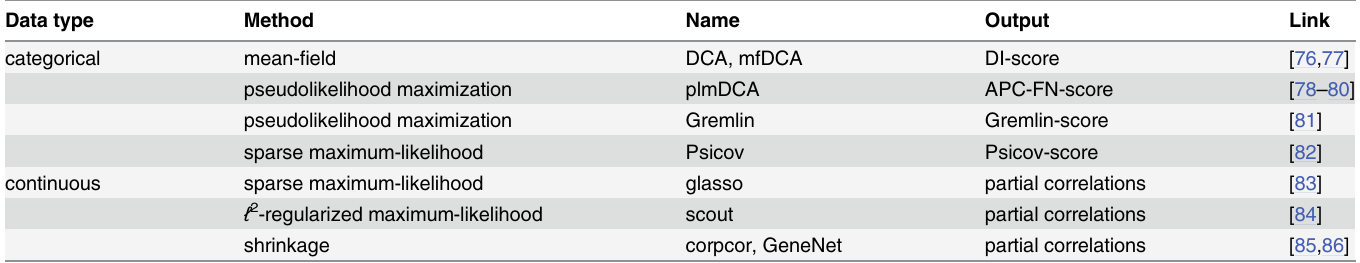
Table 1. Overview of software tools to infer pairwise interactions from datasets in continuous or categorical variables with maximum-entropy/ GGM-based